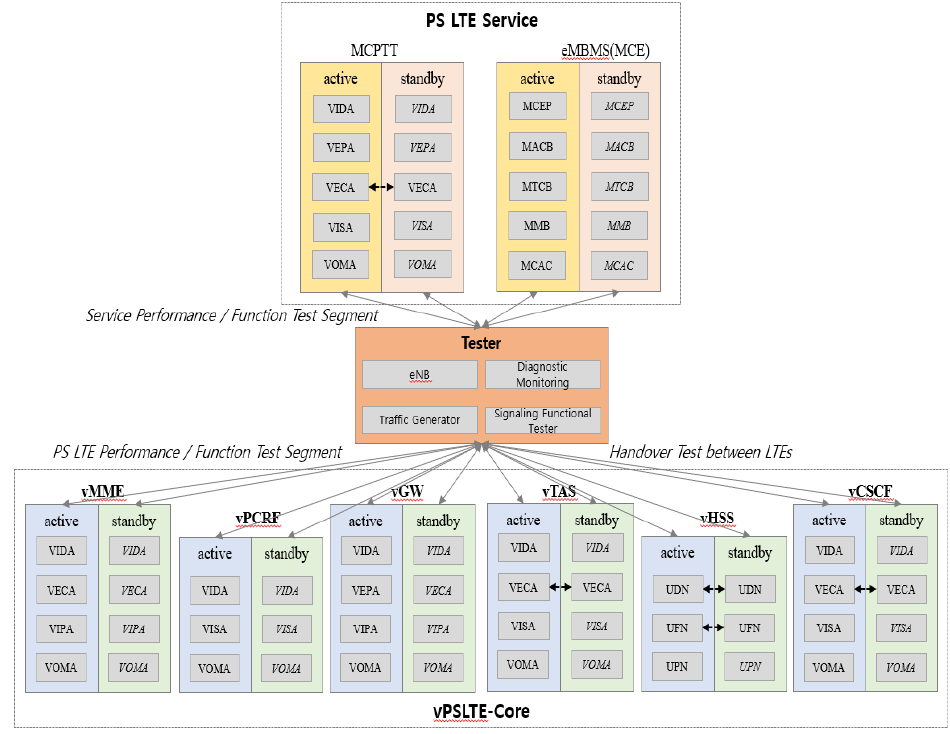
Figure 1. Block diagram of core equipment test environment.